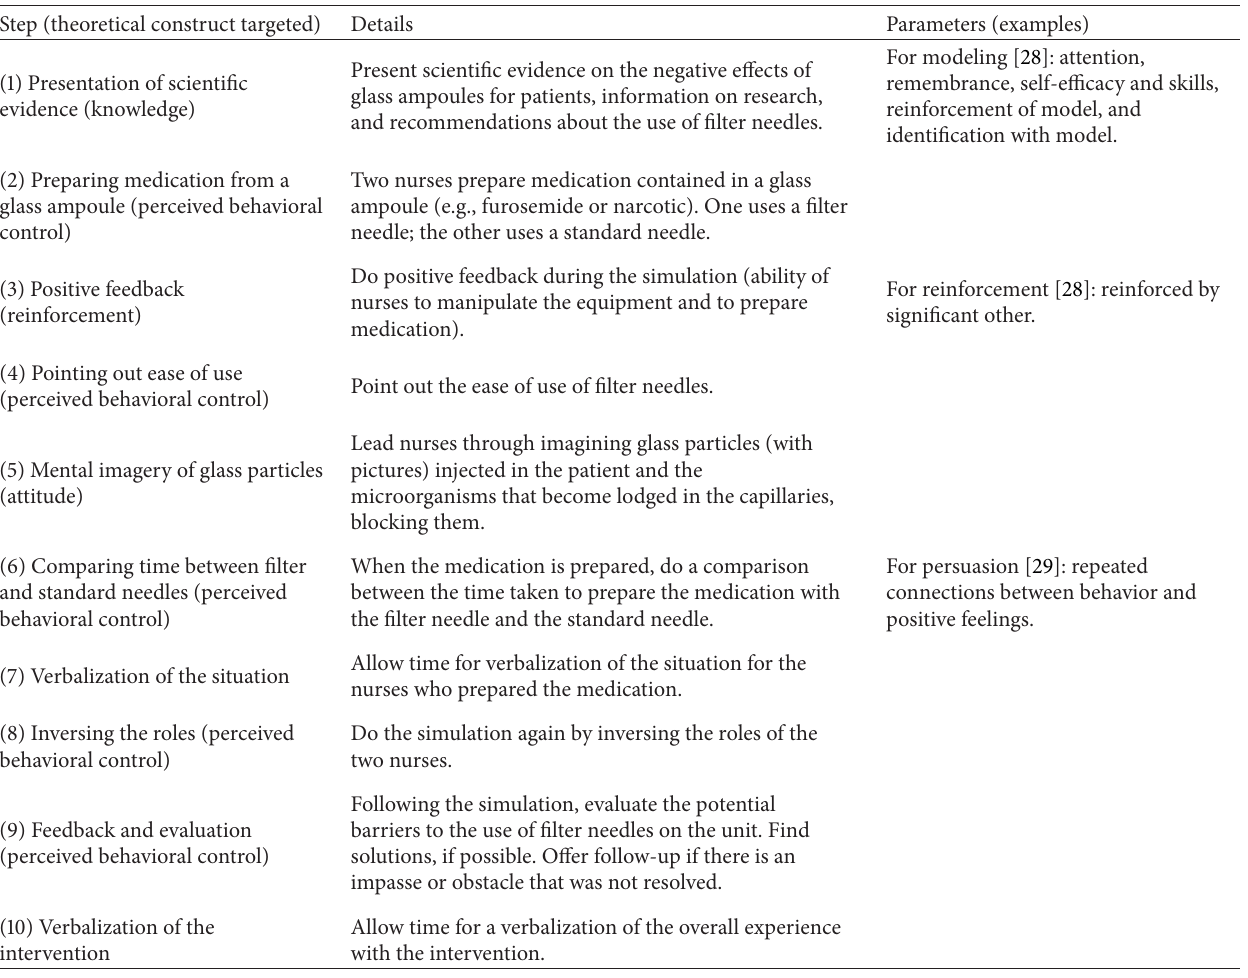
Table 1: Details of the simulation